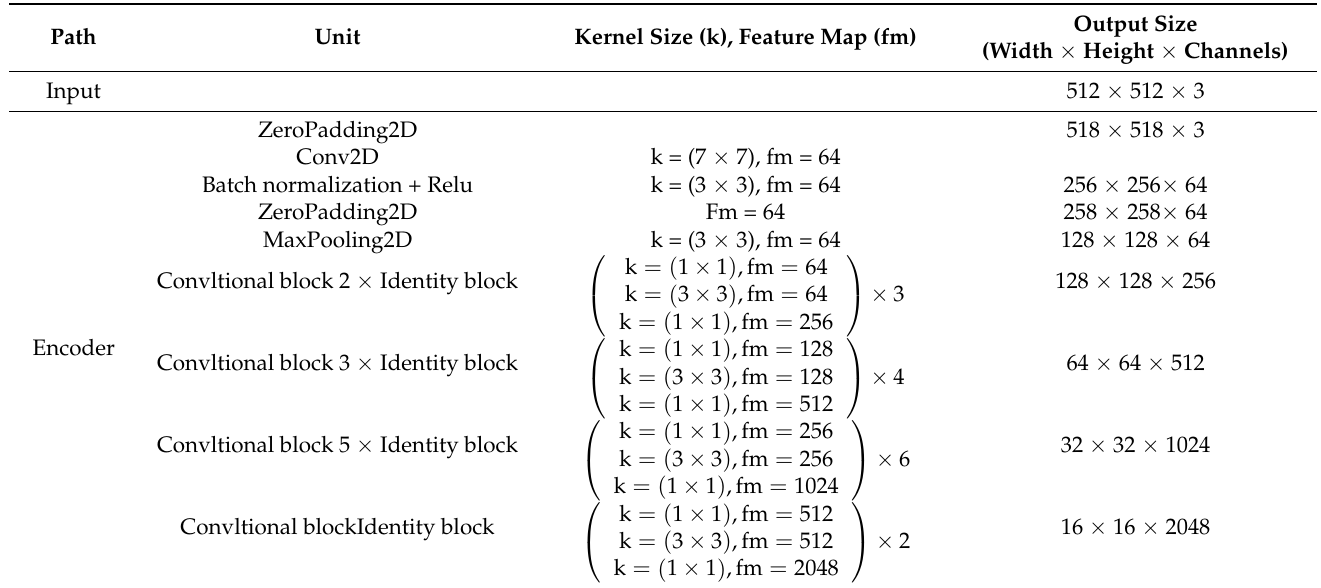
Figure 3. U-Net architecture based on ResNet-50 adopted in this study. Table 1. The architecture of the proposed U-Net